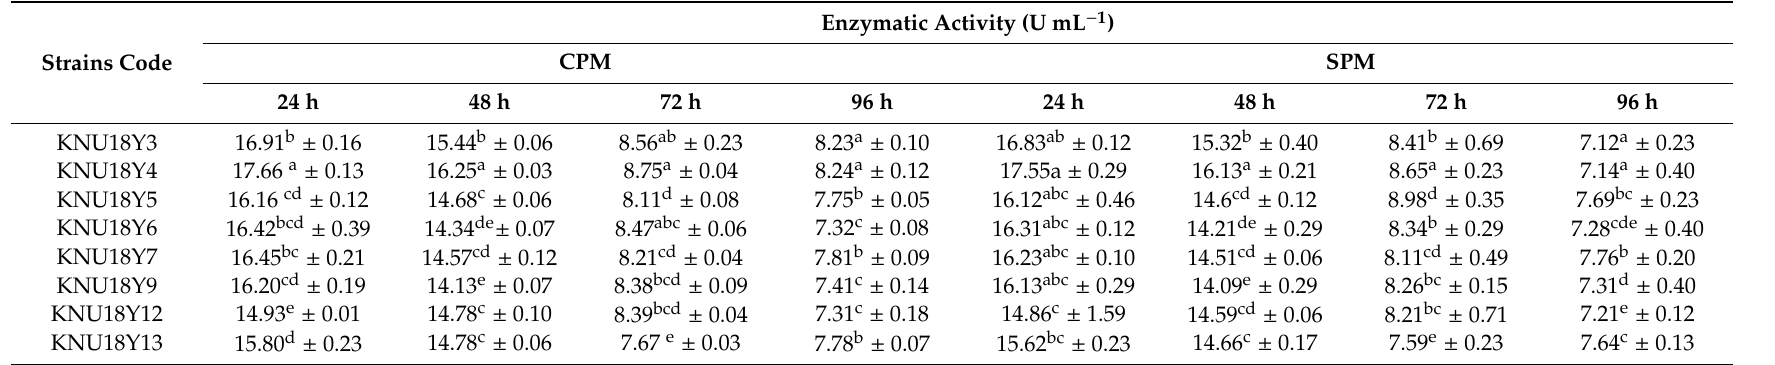
Table 7. Pectin lyase (PL) activity of the yeasts after fermentation in CPM and SPM (24, 48, 72, and 96 h).